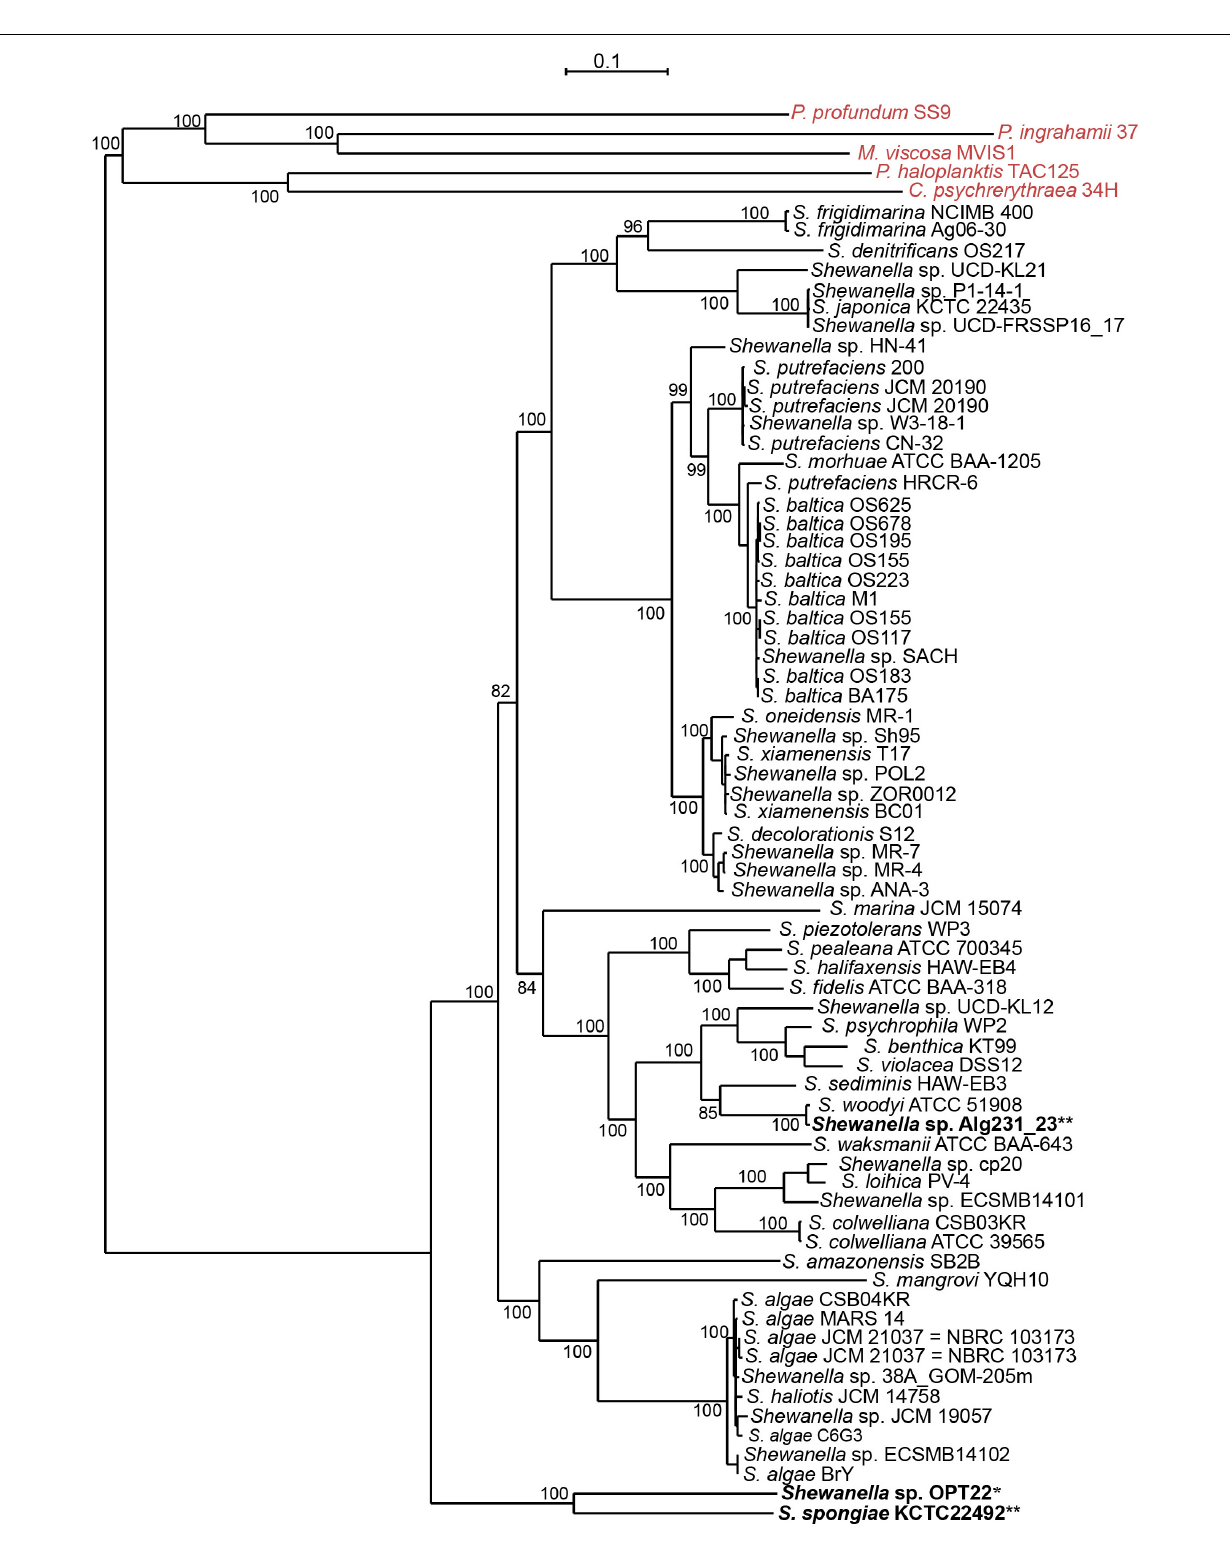
Frontiers in Microbiology |